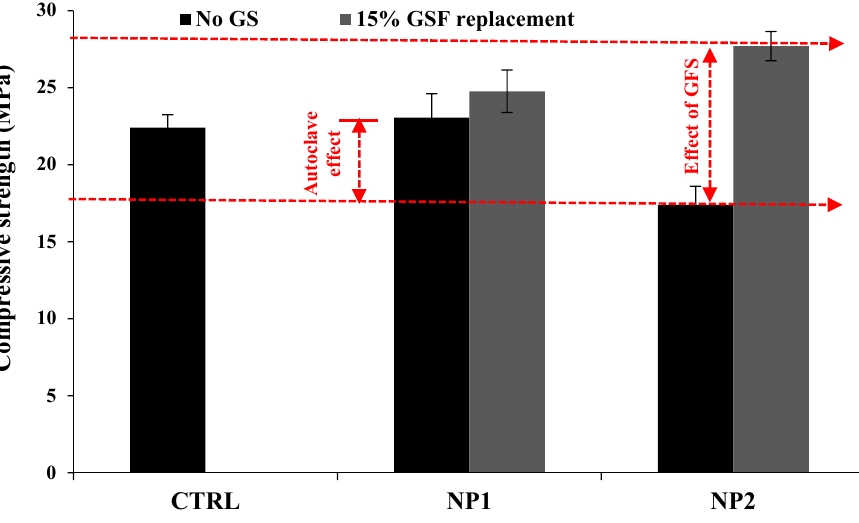
Figure 9. Performance of 25% NP1 and NP2 with 15% ground silica flour.